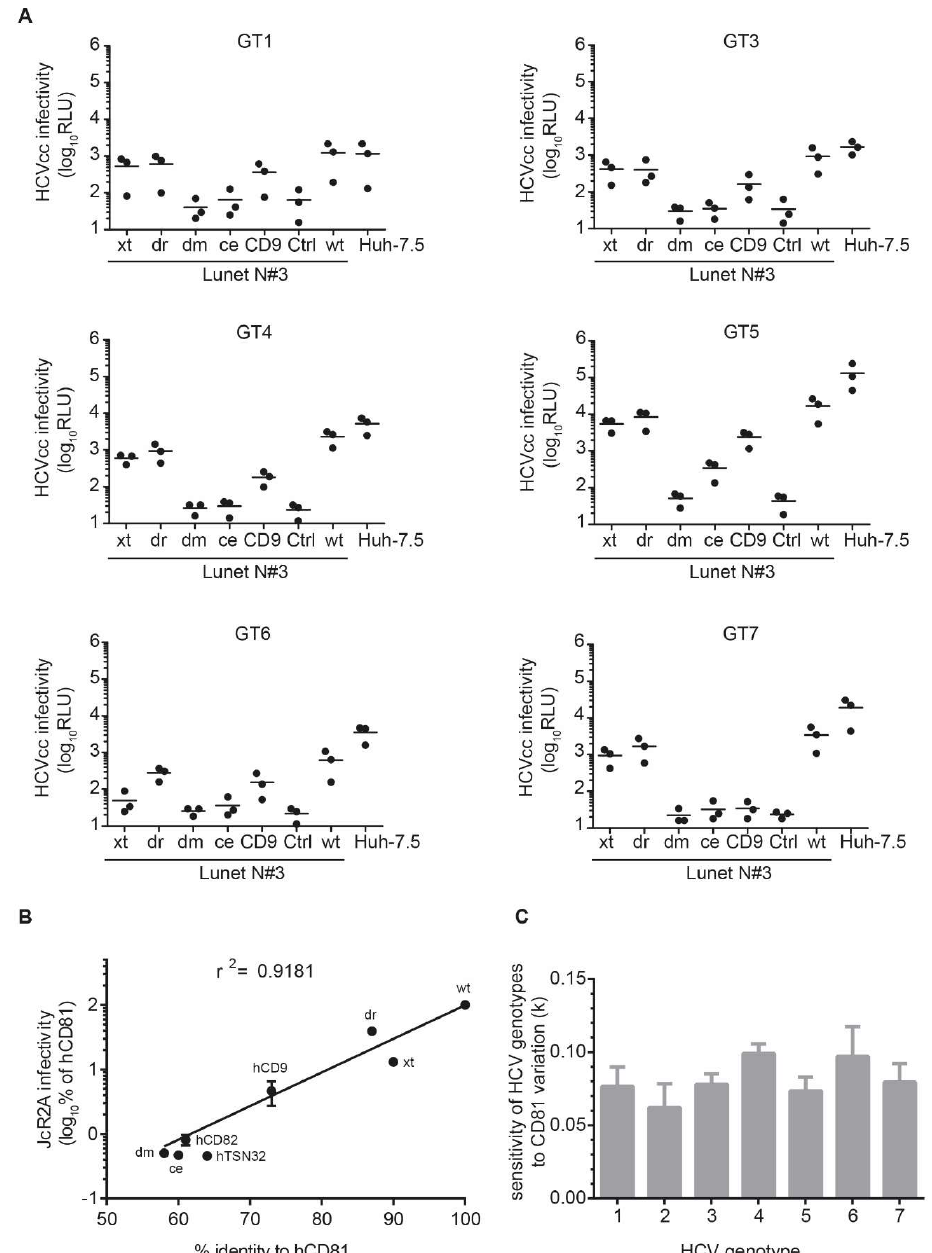
Figure 7. HCV genotypes similarly depend on the hCD81 backbone. ( A ) Lunet N#3 cells expressing the hCD81 chimeras and Huh-7.5 cells were infected with intergenotypic chimeric viruses encoding Renilla luciferase reporter. At 72 hpi, cell lysates were analyzed for luciferase activity as a measure of HCV infectivity. Graphs show three independent biological replicates (mean of technical triplicates each); ( B ) Influence of CD81 variation on HCV susceptibility of Lunet N#3 cells. The HCV genotype 2a susceptibility (normalized to hCD81 expressing Lunet N#3 cells) is plotted on the y axis and the identity of the respective CD81 chimera to hCD81 on the x axis. Exponential growth regression analysis with all negative values excluded from analysis; ( C ) Sensitivity of HCV genotypes to CD81 backbone variation plotted as rate constant (k) of the exponential growth regression analysis for HCV genotype 1–7 intergenotypic chimeras. Statistical significance in ( C ) tested by ANOVA with no significant differences observed.